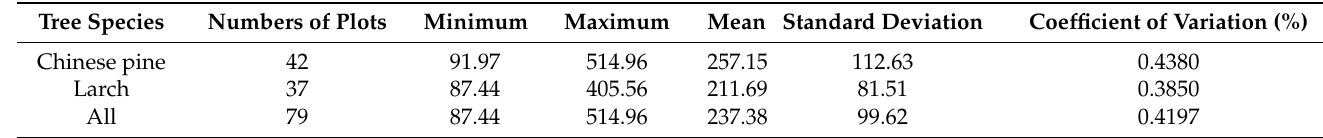
Figure 2. ( a ) Plot distribution map and digital elevation model (DEM) of the study area; ( b , c ) images of Chinese pine and larch at the field survey sites, respectively. Table 1. Statistical summary of the growing stem volume (m 3 /ha) at the field plots. Tree